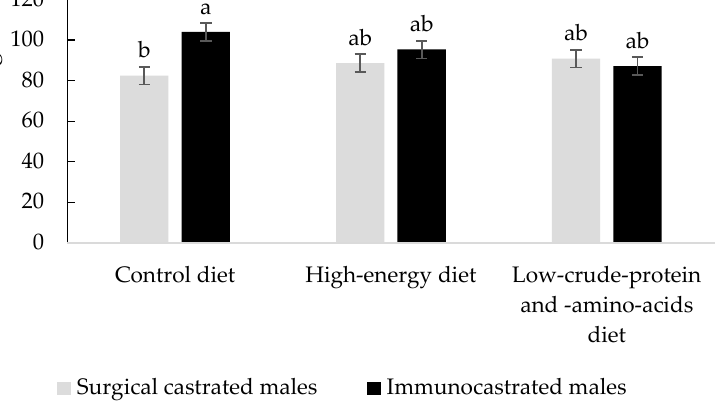
Figure 2. Interaction type of castration × diet ( p = 0.032) on serum cholesterol concentration ( n = 6). Least square means that differ significantly ( p < 0.05) are noted with different letters (a, b).